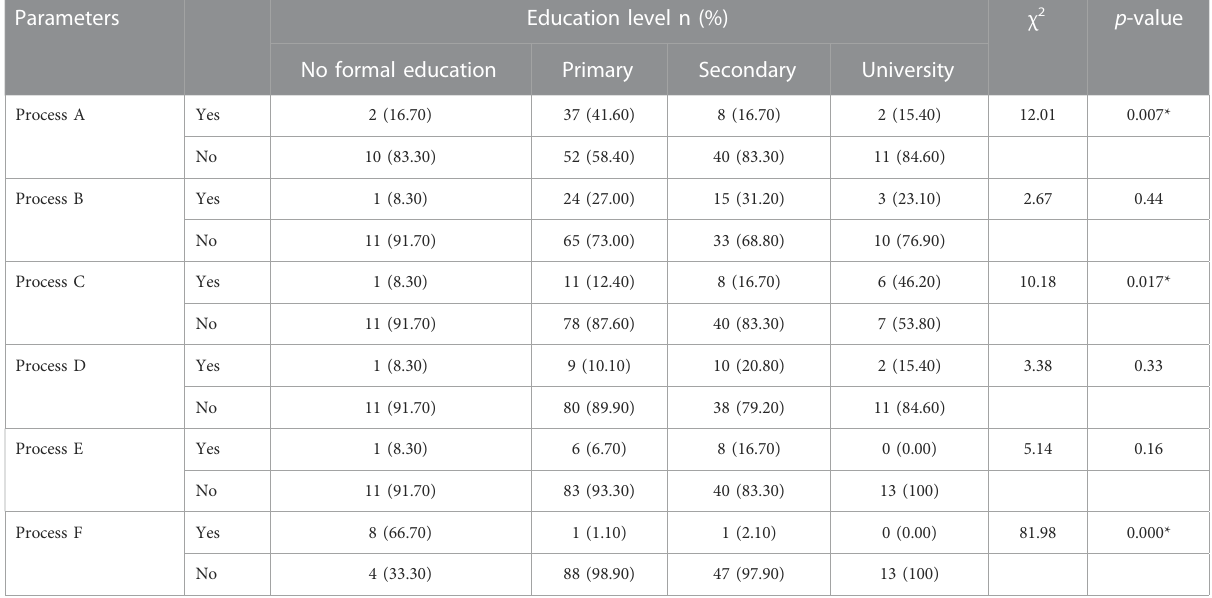
TABLE 3 Correlation between education level and cleaning process of recovered plastic bottles in the city of Yaoundé.